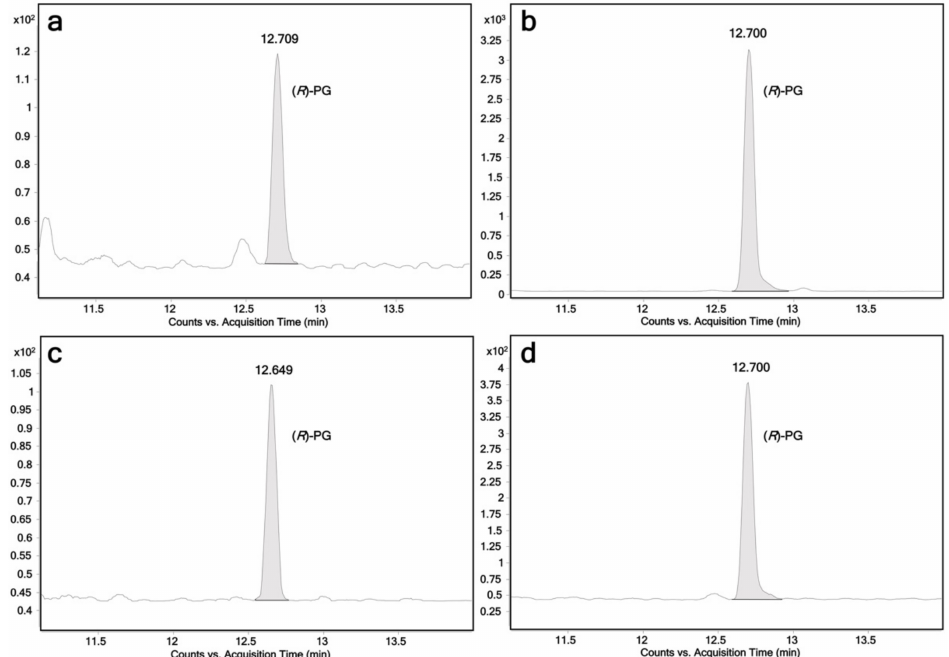
Figure 2. Chromatograms of ( R )-propranolol glucuronide obtained from individual UGT reac- tions using ( R )-propranolol as the substrate. Ion transition m / z 436 → 116 is monitored; ( R )-PG: ( R )-propranolol glucuronide, retention time 12.7 min; ( a ) UGT1A7; ( b ) UGT1A9; ( c ) UGT1A10; ( d )